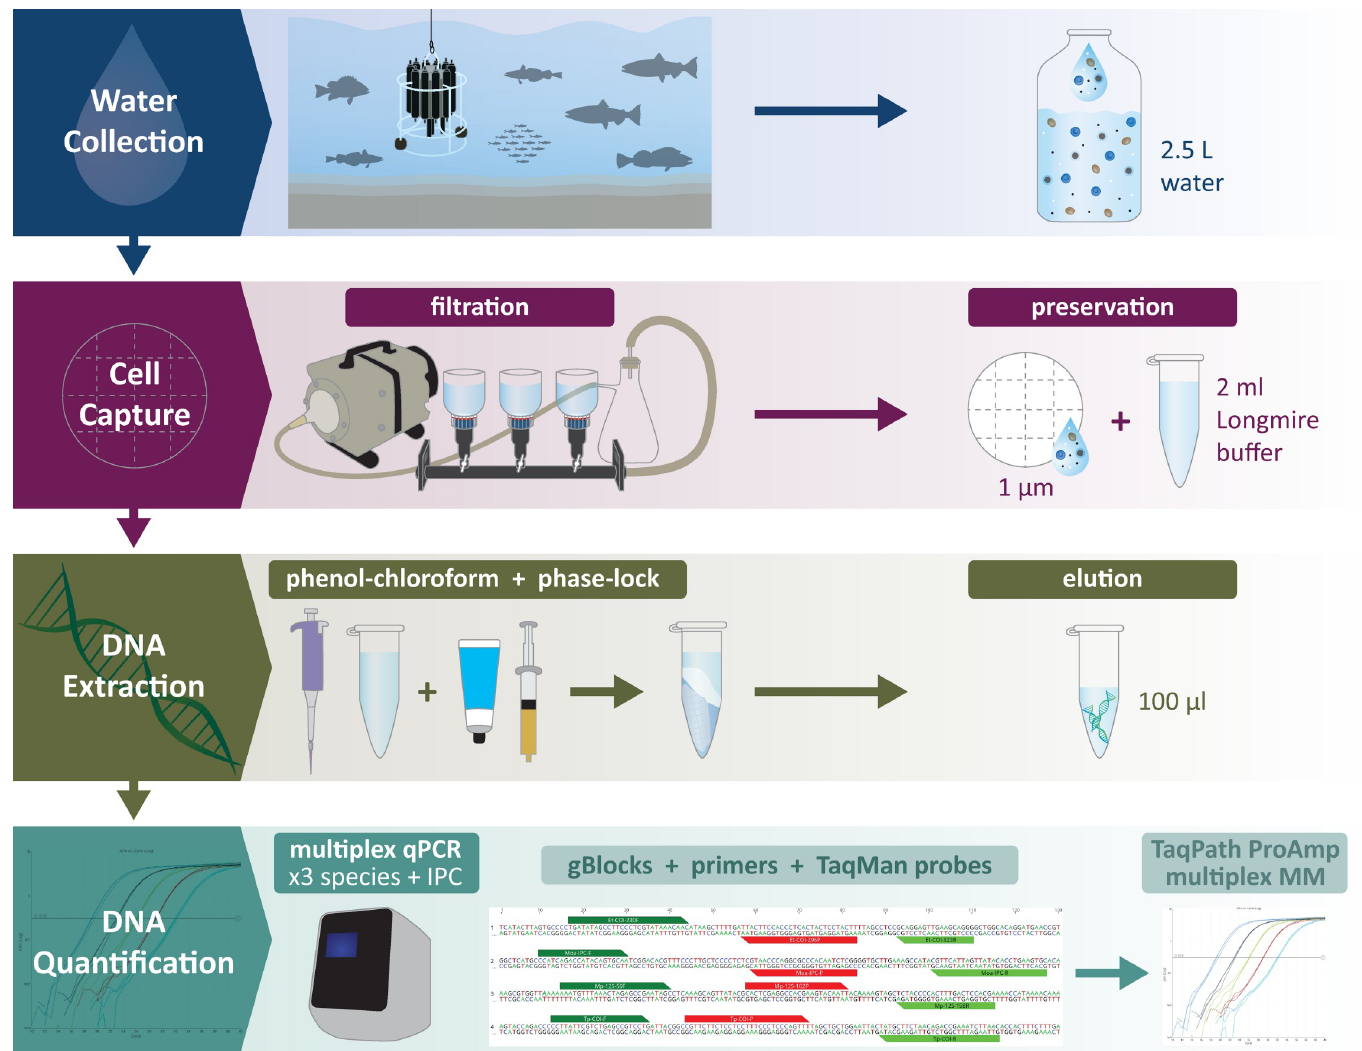
Fig 1. Final workflow proposed after methods evaluation. Water samples are collected at different depths using Niskin bottles on a CTD rosette and filtered immediately after. The filters are preserved in tubes with Longmire’s buffer and the DNA is extracted using a phase-lock/phenol-chloroform extraction. Target DNA is analyzed in a multiplex qPCR assay (details in S3 File). Illustration by Su Kim, NWFSC/NOAA